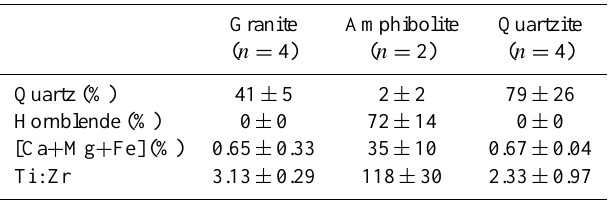
Table 3. Summary of key parent material mineral and geochemical